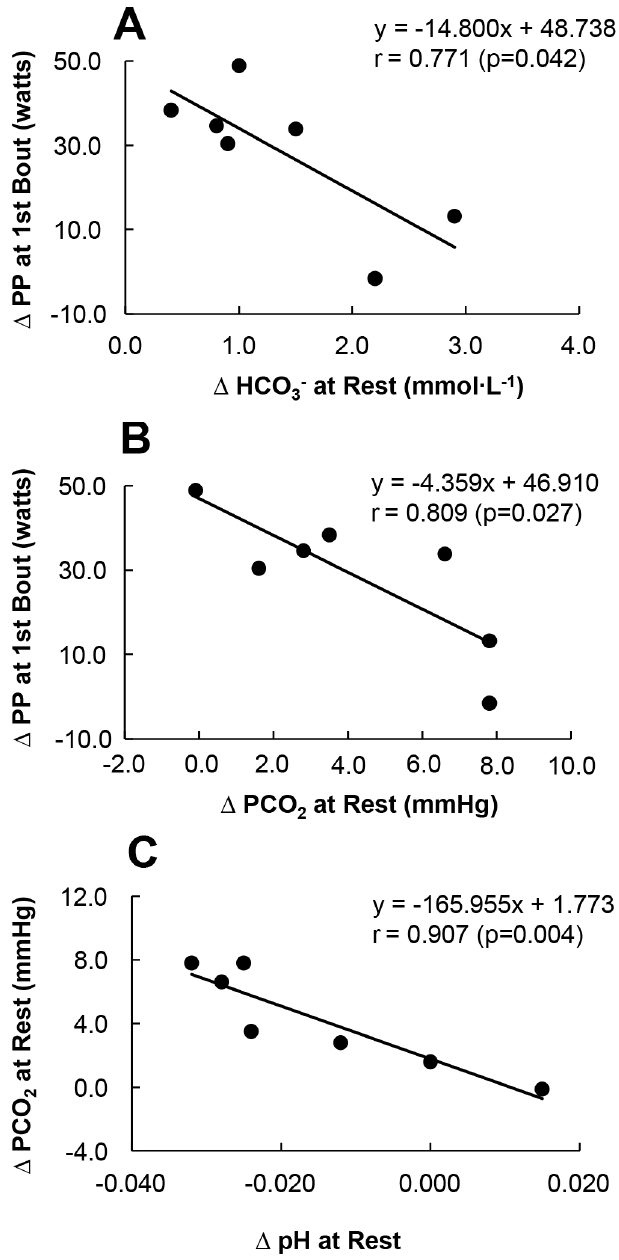
Figure 5. The relationship between changes in the peak power (PP) at the 1st bout ( Δ PP (HCP − Placebo)) and changes in the HCO 3 − value at rest ( Δ HCO 3 − (HCP − Placebo)) ( A ), the Δ PP at the 1st bout and changes in the PCO 2 at rest ( Δ PCO 2 (HCP − Placebo)) ( B ), and the Δ PCO 2 at rest in relation to the